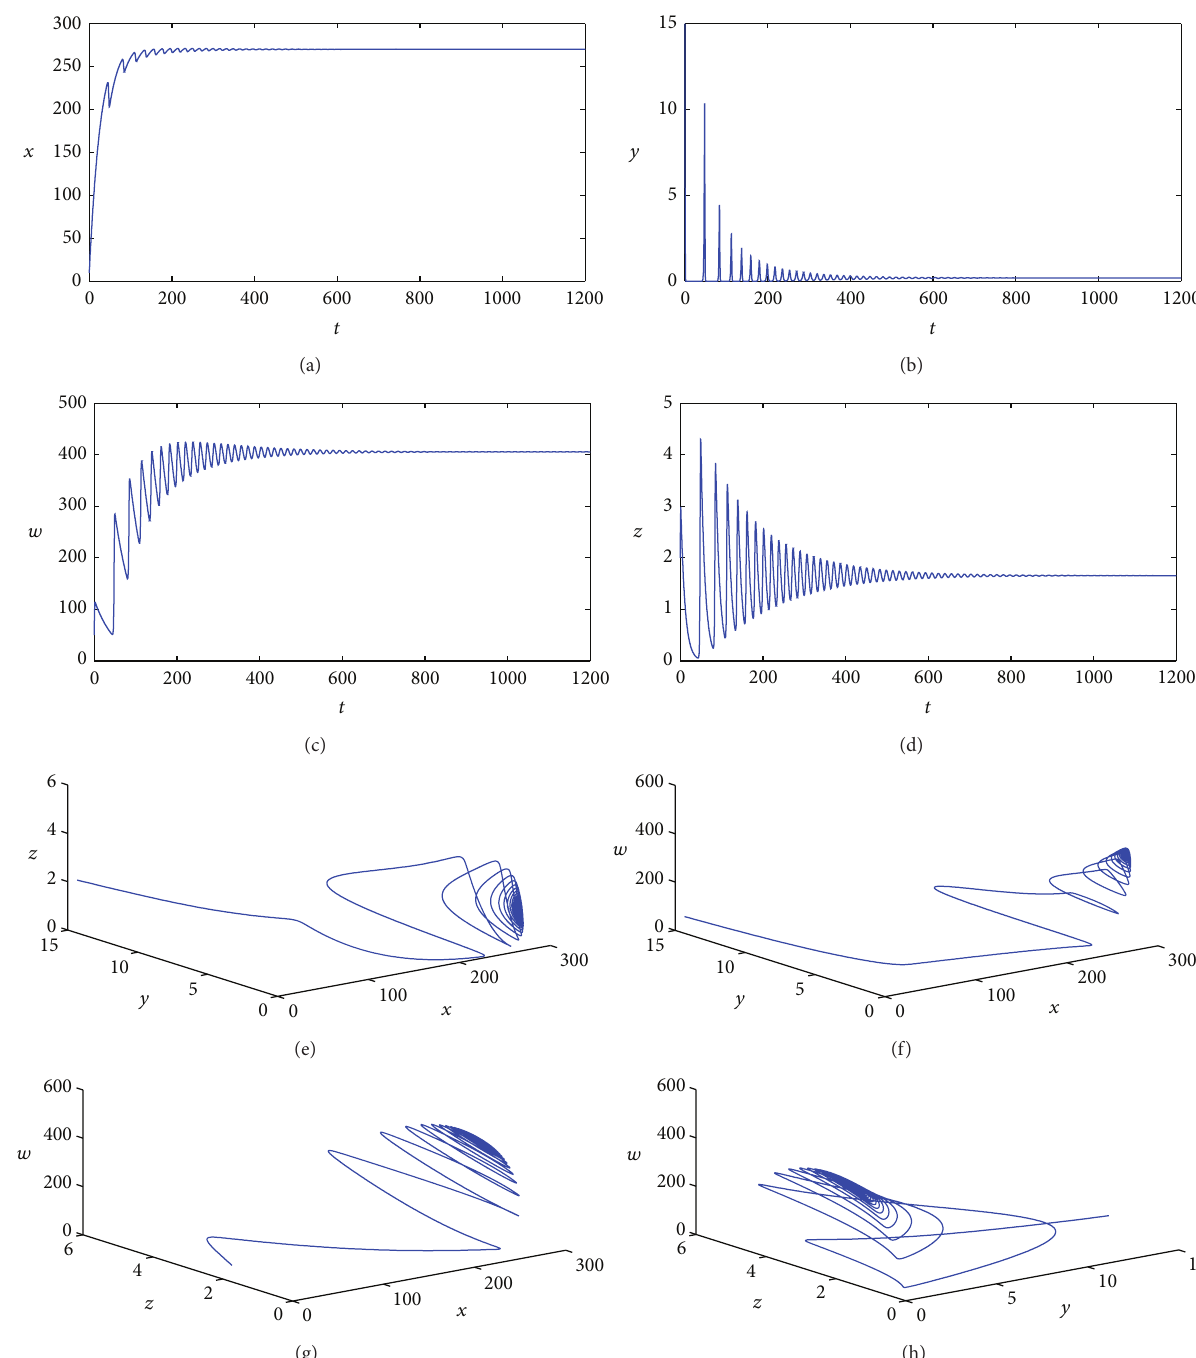
Figure 2: Each panel (from (a) to (h)) shows the time evolution and trajectory of model (4) when 𝜏(= 0.4) < 𝜏 0 (critical value) and the effect of therapies is considered to be 𝜖 = 0.9 and 𝜂 = 0.2 . It shows that the endemic steady state E + of model is asymptotically stable.